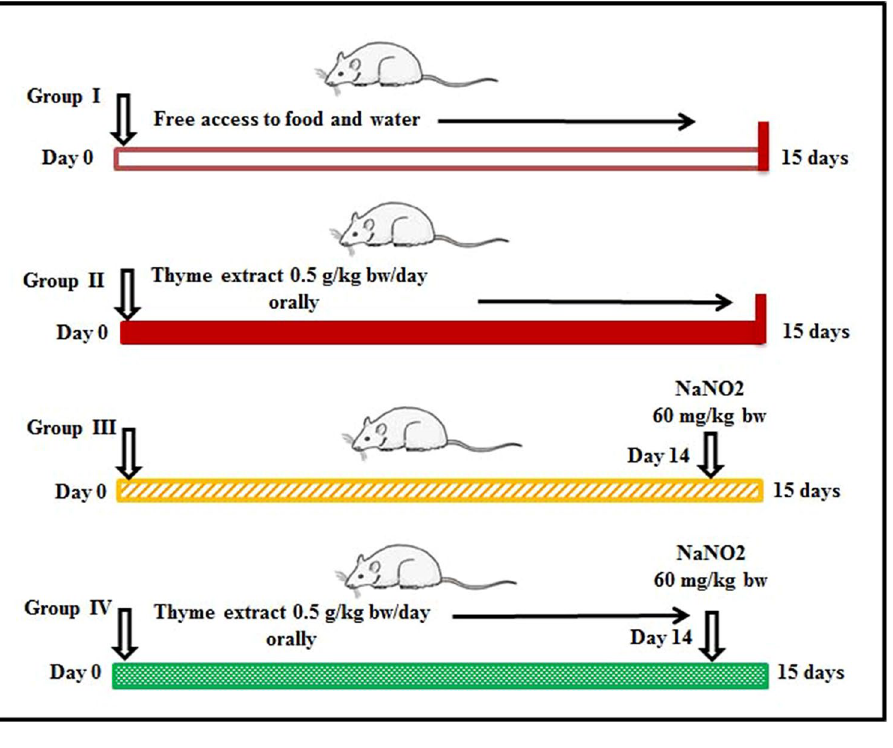
Figure 1. Schematic diagram showing the experimental